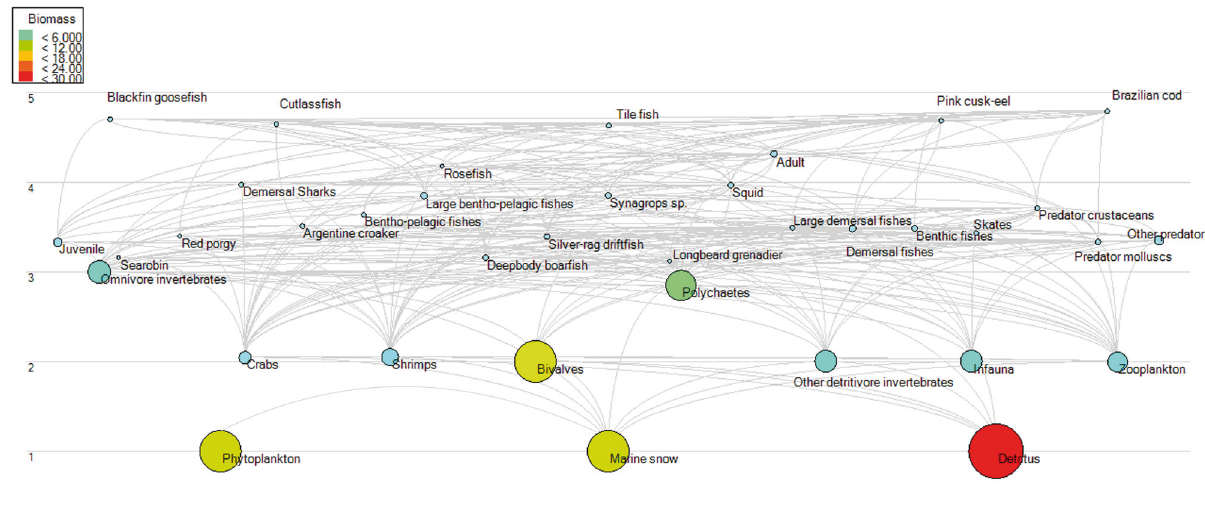
Fig. 2. – Trophic flow of demersal community of the outer continental shelf and upper slope of Southeastern Brazilian Bight the, size of the circles are proportional of its